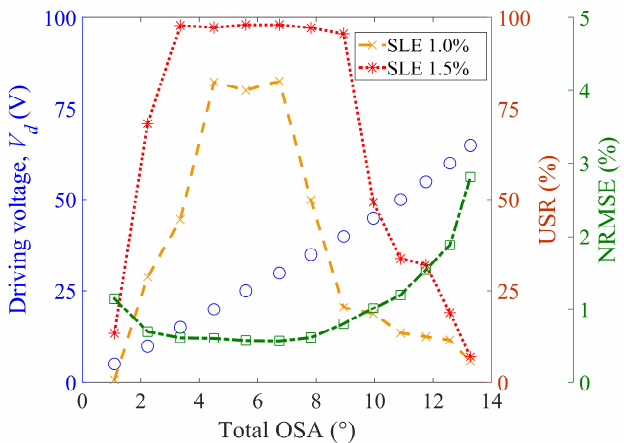
Figure 9. Experimental performance of the proposed input shaping with respect to the total optical scan angle (total OSA) (driving frequency: 20 Hz, sampling rate: 50 kHz): driving voltage with respect to total optical scan angle (circles in blue), usable scan range (dashed lines), and normalized root-mean-square error (NRMSE) (dash-dotted line in